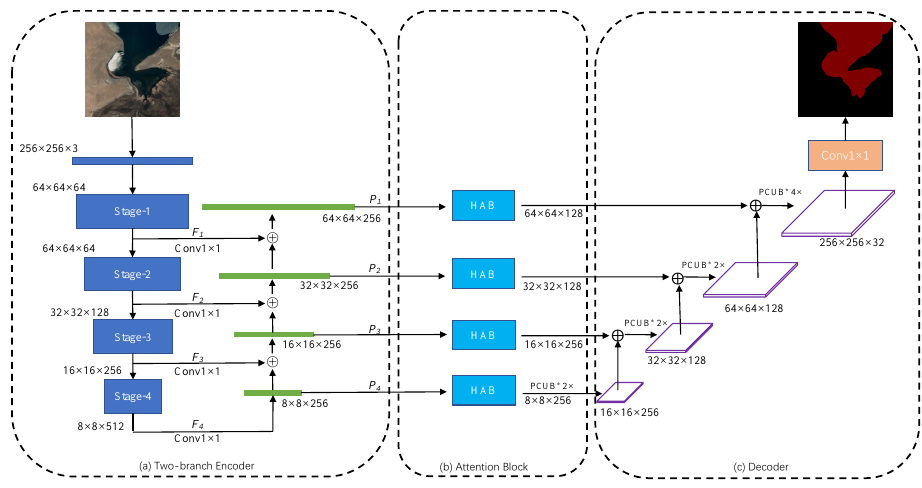
Figure 1. The structure of the hybrid-scale attention network used in this paper. ( a ) Two-branch encoder; ( b ) Attention block; ( c )